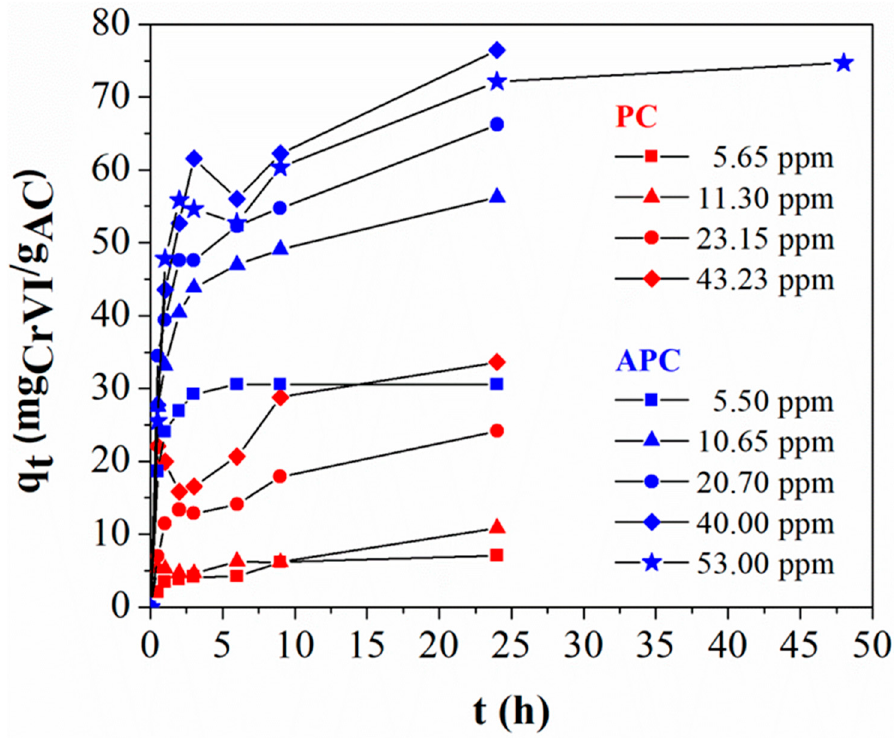
Figure 11. Kinetics and capacity comparison for various initial concentrations of PC and APC.